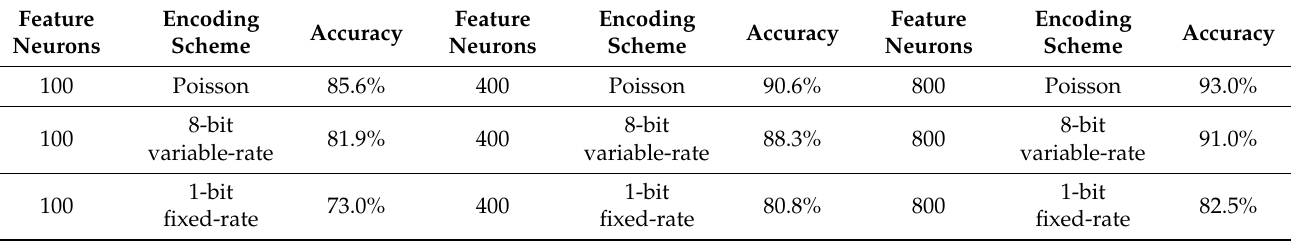
Table 2. The impact of different encoding methods on accuracy.